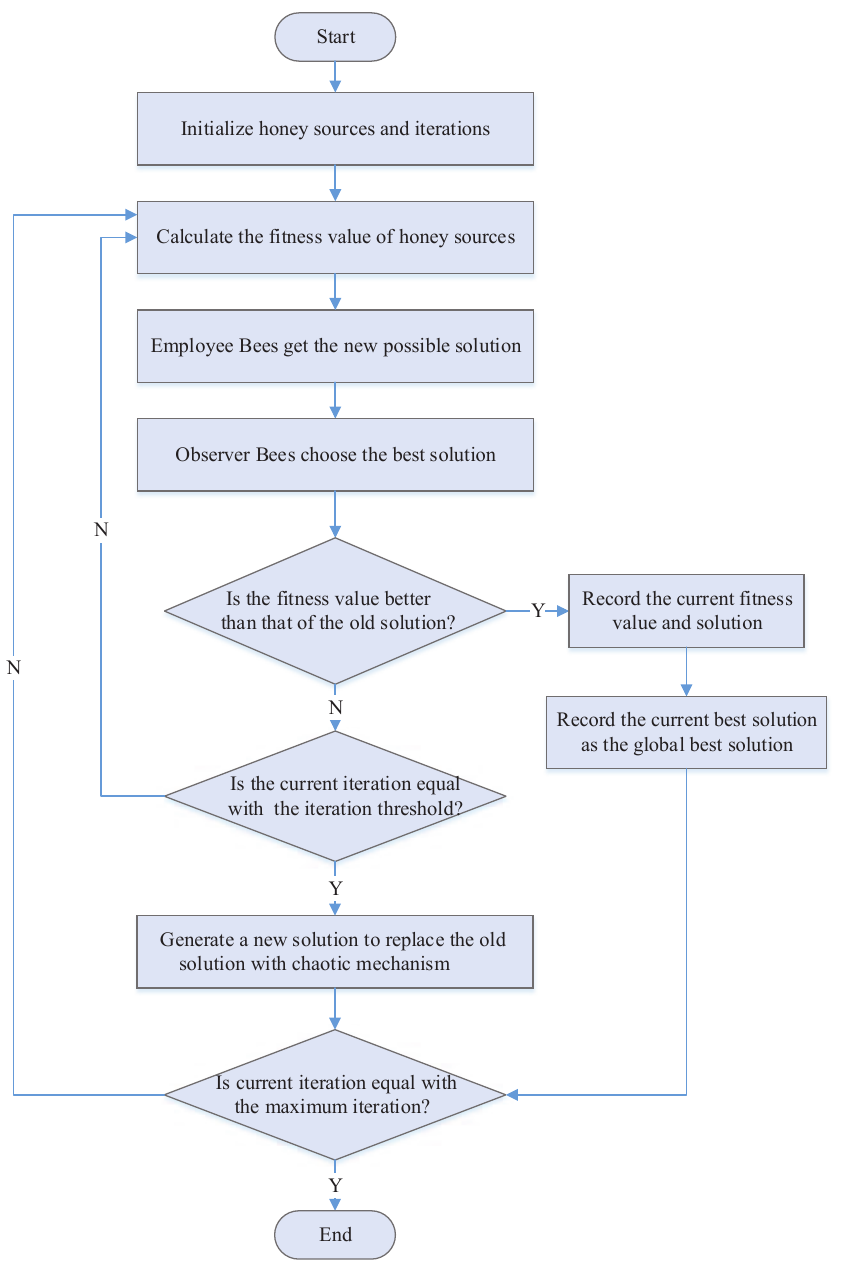
Figure 5. Flowchart of GMBCOS